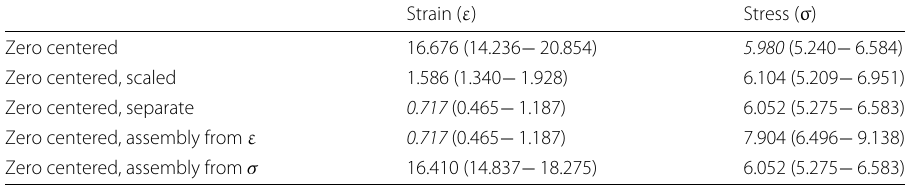
Table 5 Mean of the total reconstruction RMSRE ( · 10 − 2 ) using a full basis ( K = 149) over 5 training sets of the pure bending model